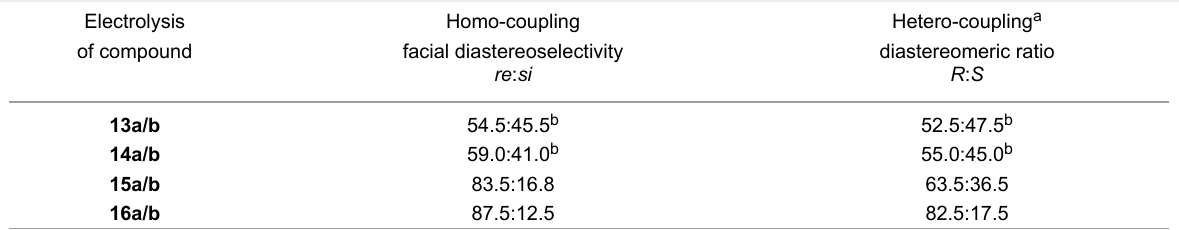
Table 3: Comparison of the diastereoselectivity in hetero- and homo-coupling reactions. Electrolysis